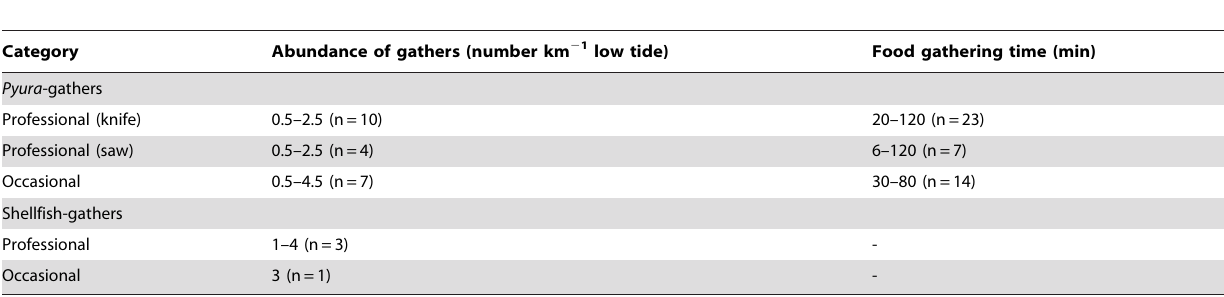
Table 1. Standardized abundance of food-gathers and time spent on extraction activities in Antofagasta Bay (C. Coloso, El Way, AAA and Trocadero, Fig. 1) between 2009 and 2014.